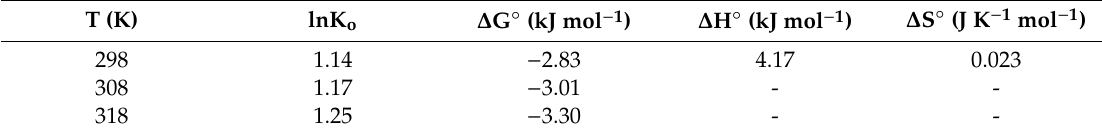
Table 4. Thermodynamic parameters for adsorption of DCF on